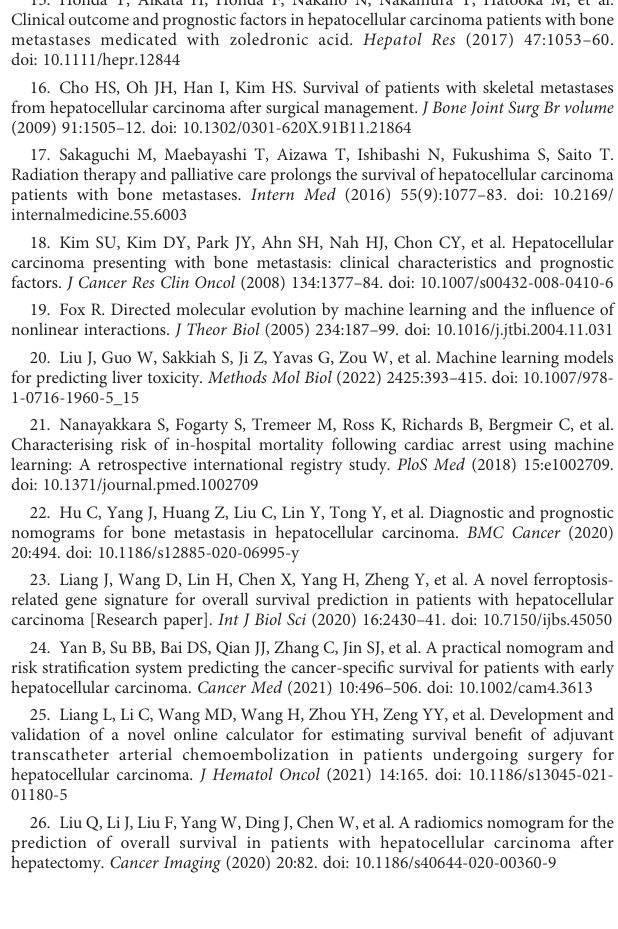
SUPPLEMENTARY FIGURE 3 Discrimination slope of the models in the internal testing cohort. A, Neural network; B, gradient boosting decision tree; C, eXGBoosting machine; D, decision tree; E, support vector machine; F, ensemble model. SUPPLEMENTARY FIGURE 4 Discrimination slope of the ensemble model in the external testing cohort. SUPPLEMENTARY FIGURE 5 Calibration plot of the ensemble model in the external testing cohort. SUPPLEMENTARY FIGURE 6 Calibration plot of the ensemble model in the external testing cohort after model revision. SUPPLEMENTARY FIGURE 7 Kaplan – Meier survival curve among patients strati fi ed by risk group (p < 0.0001, log-rank